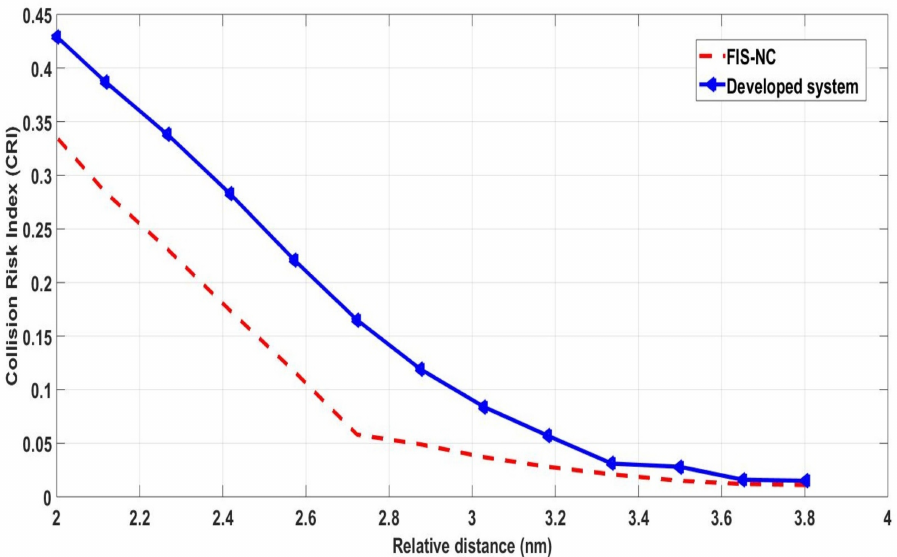
Figure 16. Comparison of results for